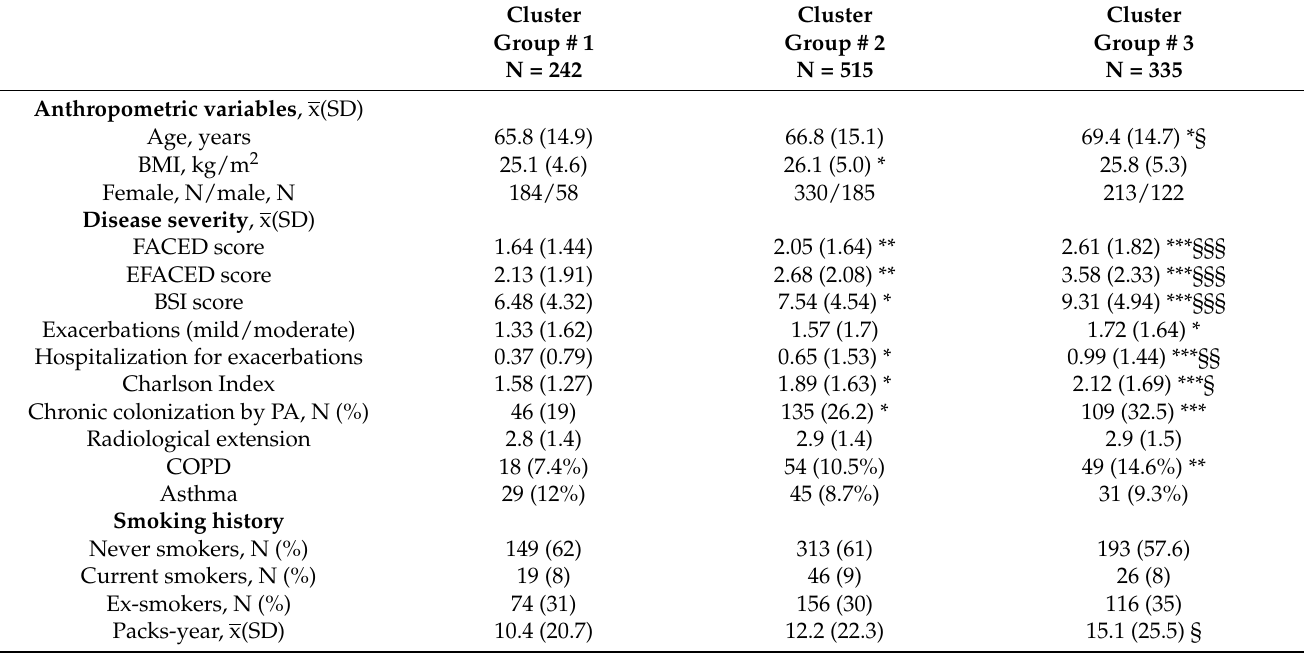
Table 2. General characteristics of all the study patients according to cluster